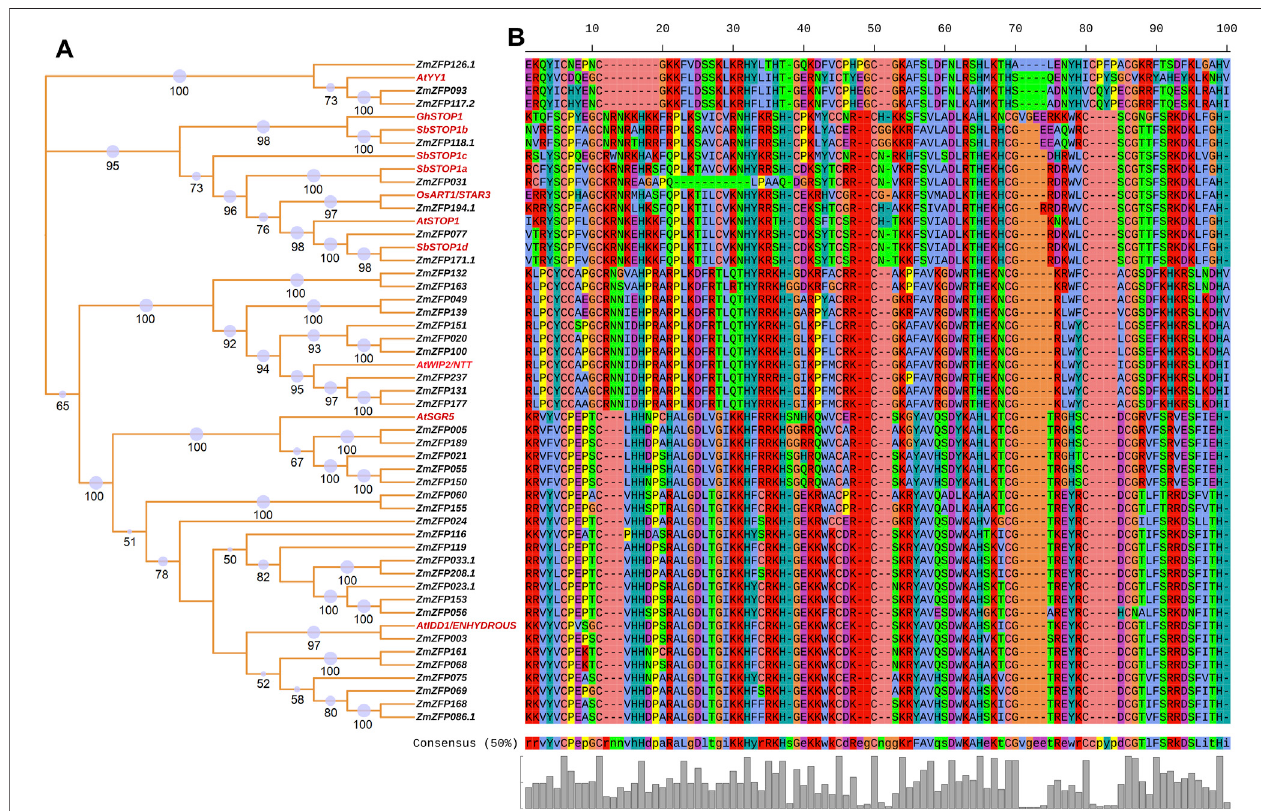
FIGURE 4 | The relationship between maize C2H2-ZF genes and other C2H2-ZF genes with known functions. (A) : NJ phylogenetic tree of the relationships betweenthe11C2H2-ZFgeneswithknownfunctionsand40maizeC2H2-ZFgenes.Theredlabels indicatedthegenewithknownfunction;Thenumberonthebranch indicatedthebootstrap value,and thesizeofthepurple circle alsoindicatedthesizeofthebootstrap value(bootstrap > 50). (B) : Thepartialconservedaminoacidmotifs of these homologous genes.